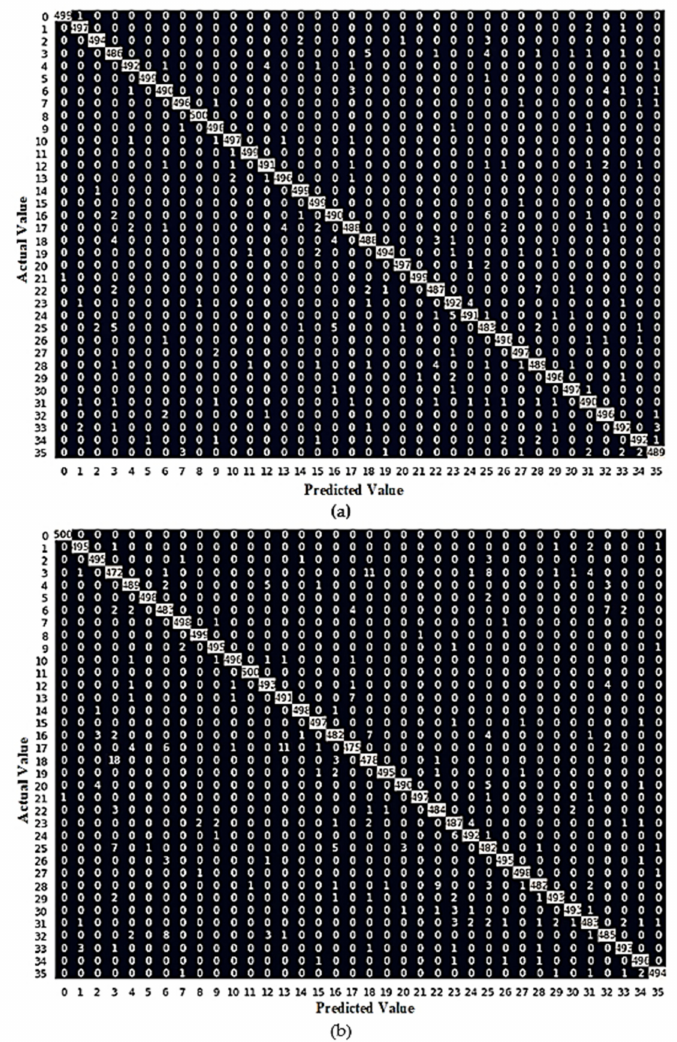
Figure 9. Confusion matrix generated for Dataset 15 by: ( a ) MLP classifier; ( b ) SVM